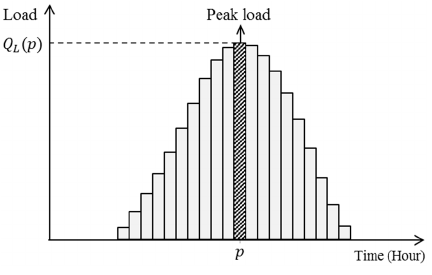
Figure 5. 24 ‐ h load profile for example.